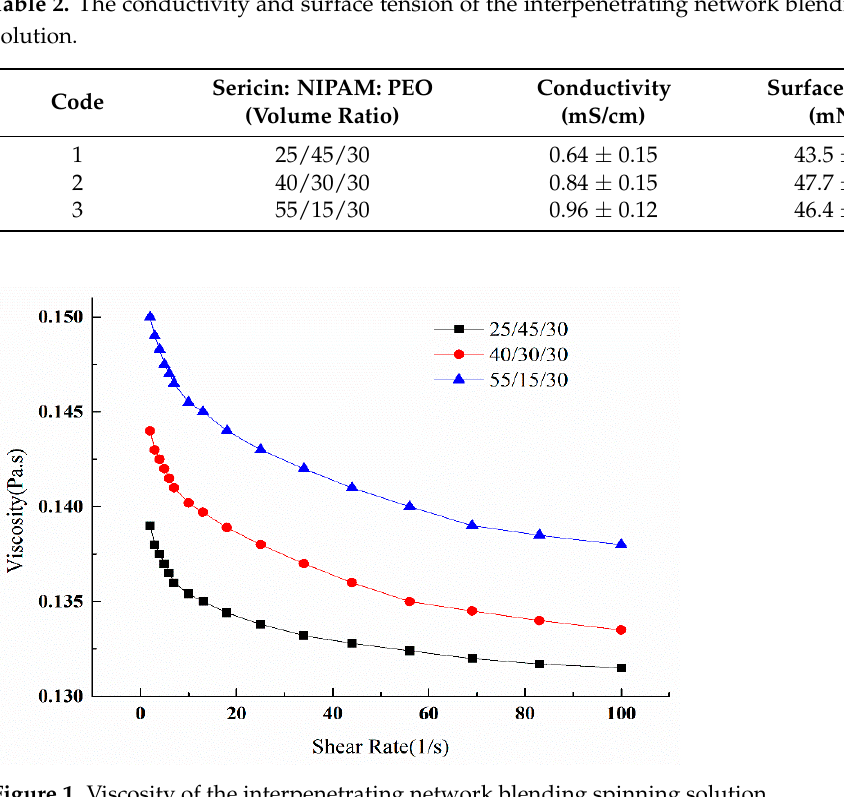
Figure 1. Viscosity of the interpenetrating network blending spinning